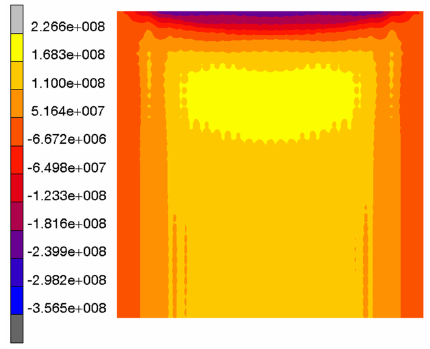
Figure 21. Stress